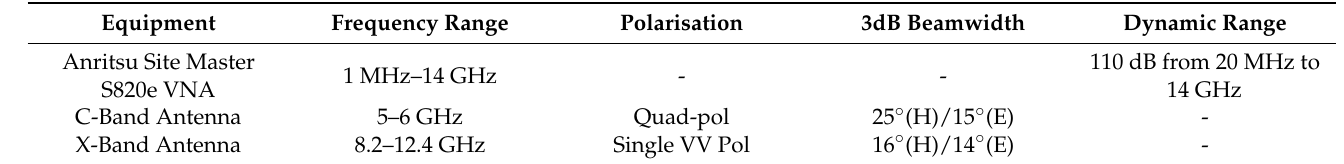
Table 3. Measuring equipment specifications for ground radar used to measure Deltares campaign